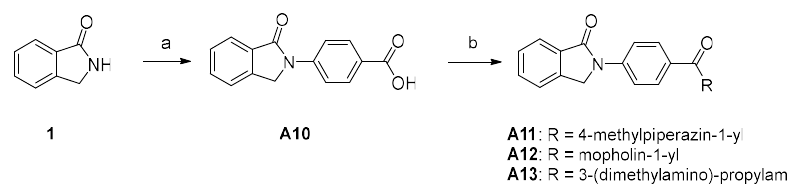
Scheme 1. Preparation of N -substitutedphenyl-isoindolin-1-ones.